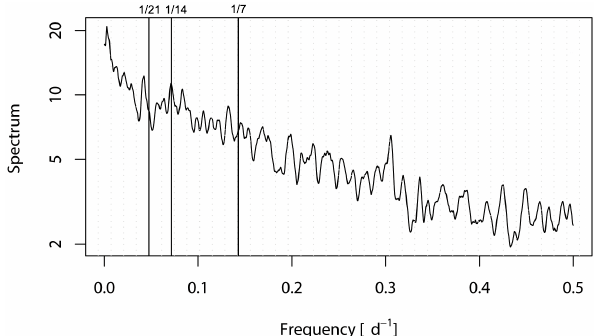
Fig. 7. Smoothed periodogram of regional mean (average of the 30 stations in the Black Triangle) daily precipitation anomaly from 1983–2008. Solid vertical lines show the frequency of a week (1/7 and multiples of